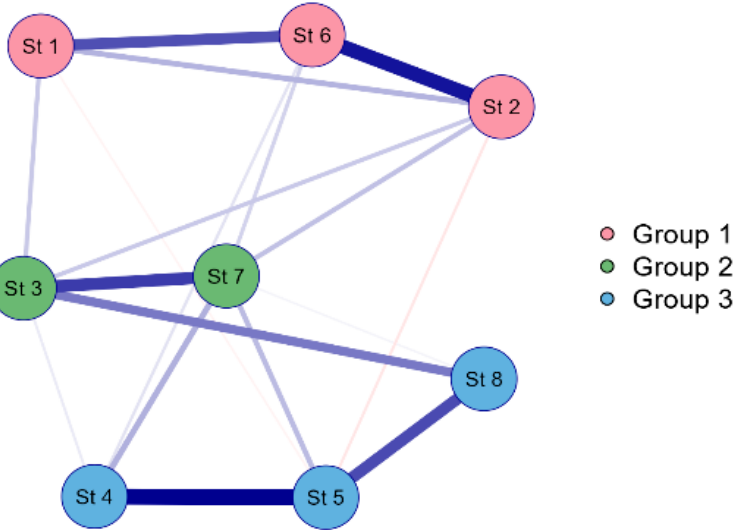
Figure 4. JASP correlation plot of the phytoplankton species richness in Lake Borovoe, 2019. Bold line shows largest similarity on type of analysis, “Huge” correlation > 0.5.